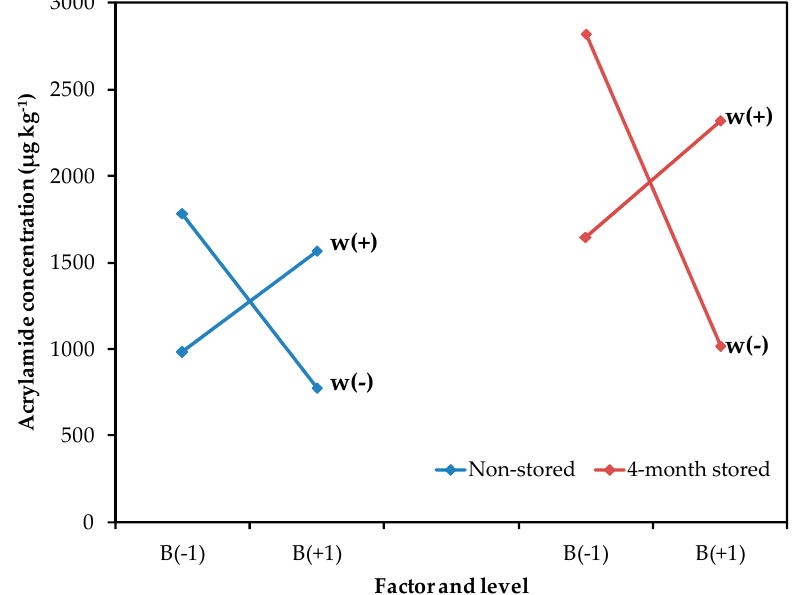
Figure 2. Mean e ff ect graph vs. acrylamide concentration ( µ g kg − 1 ) for the interaction between Figure 2. Mean effect graph vs. acrylamide concentration (µg kg − 1 ) for the interaction between blanching (B) and thickness (w) in non-stored and 4-month stored blanching (B) and thickness (w) in non-stored and 4-month stored tubers.